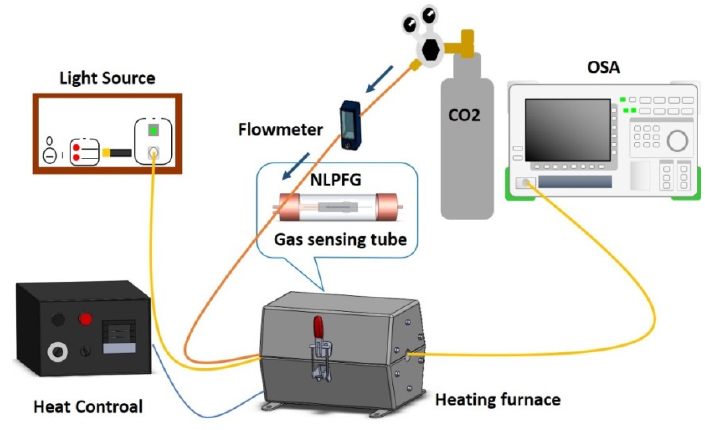
Figure 3. Experimental setup for CO 2 gas